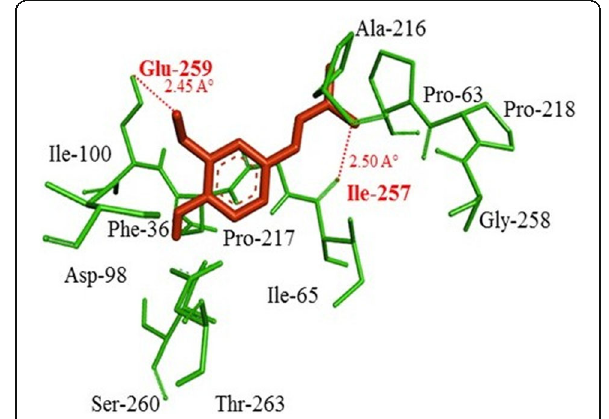
Fig. 6 Docking complexes of p -coumaric acid-Bcl2-associated X (BAX) protein